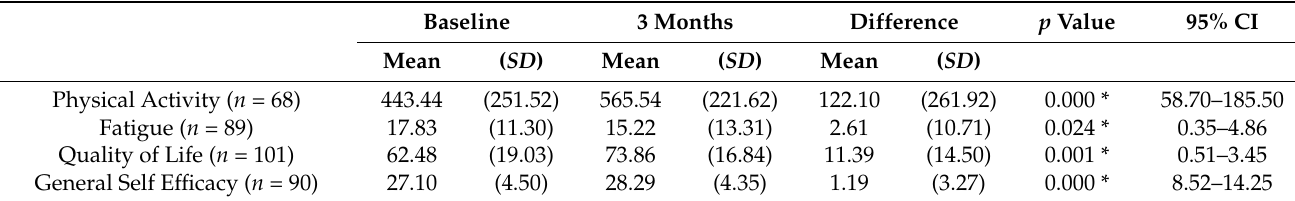
Table 4. Results of the paired samples t -test for the CaPASEF questionnaire components.